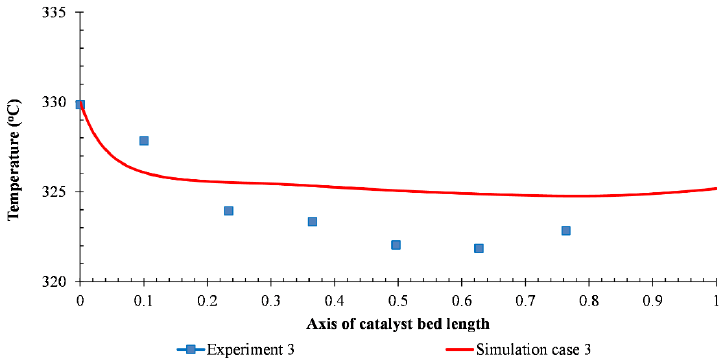
Figure 5. The temperature profile comparison between simulation and third experimental data.